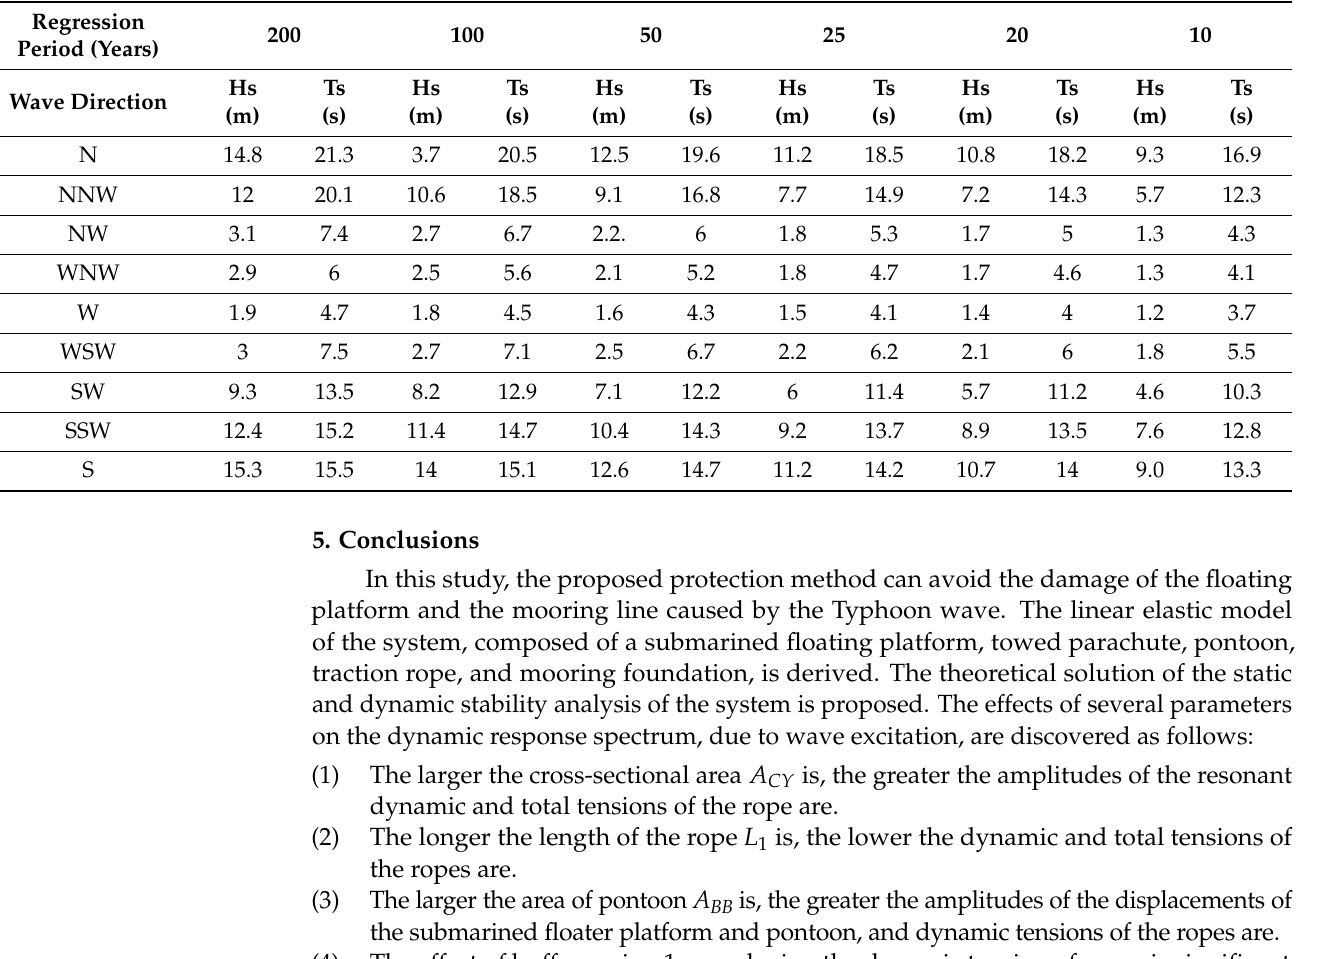
Table 3. Typhoon wave spectrum off Green Island, Taiwan